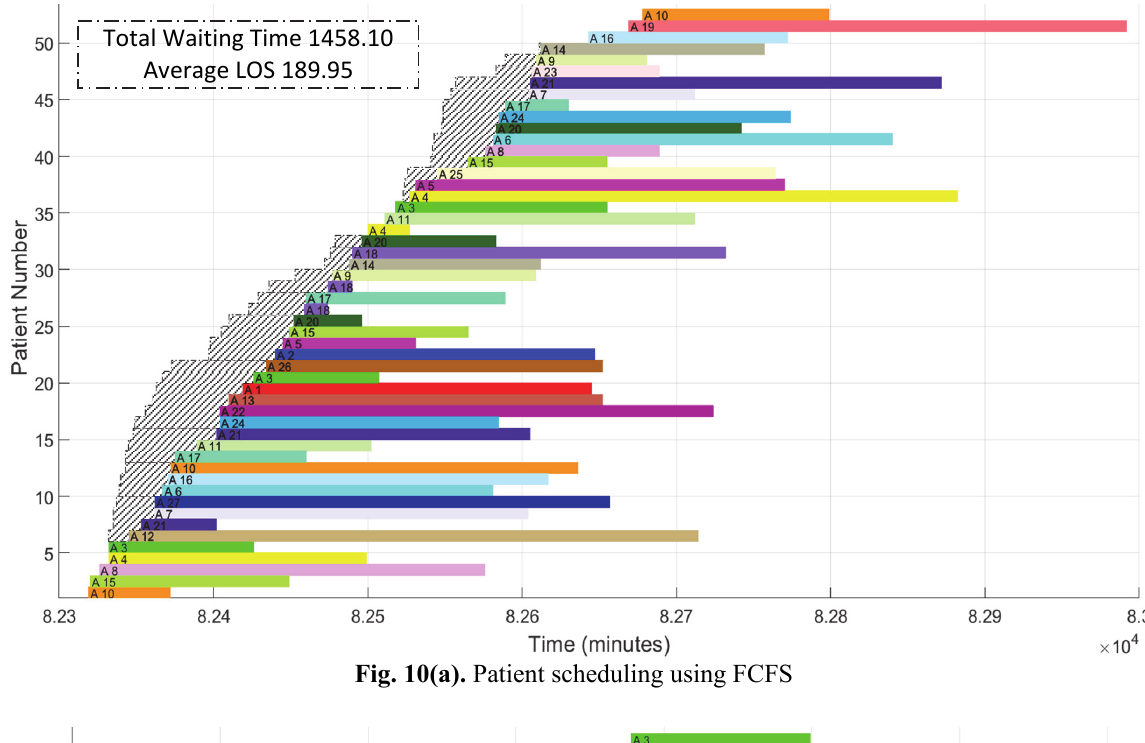
Fig. 10(a). Patient scheduling using FCFS